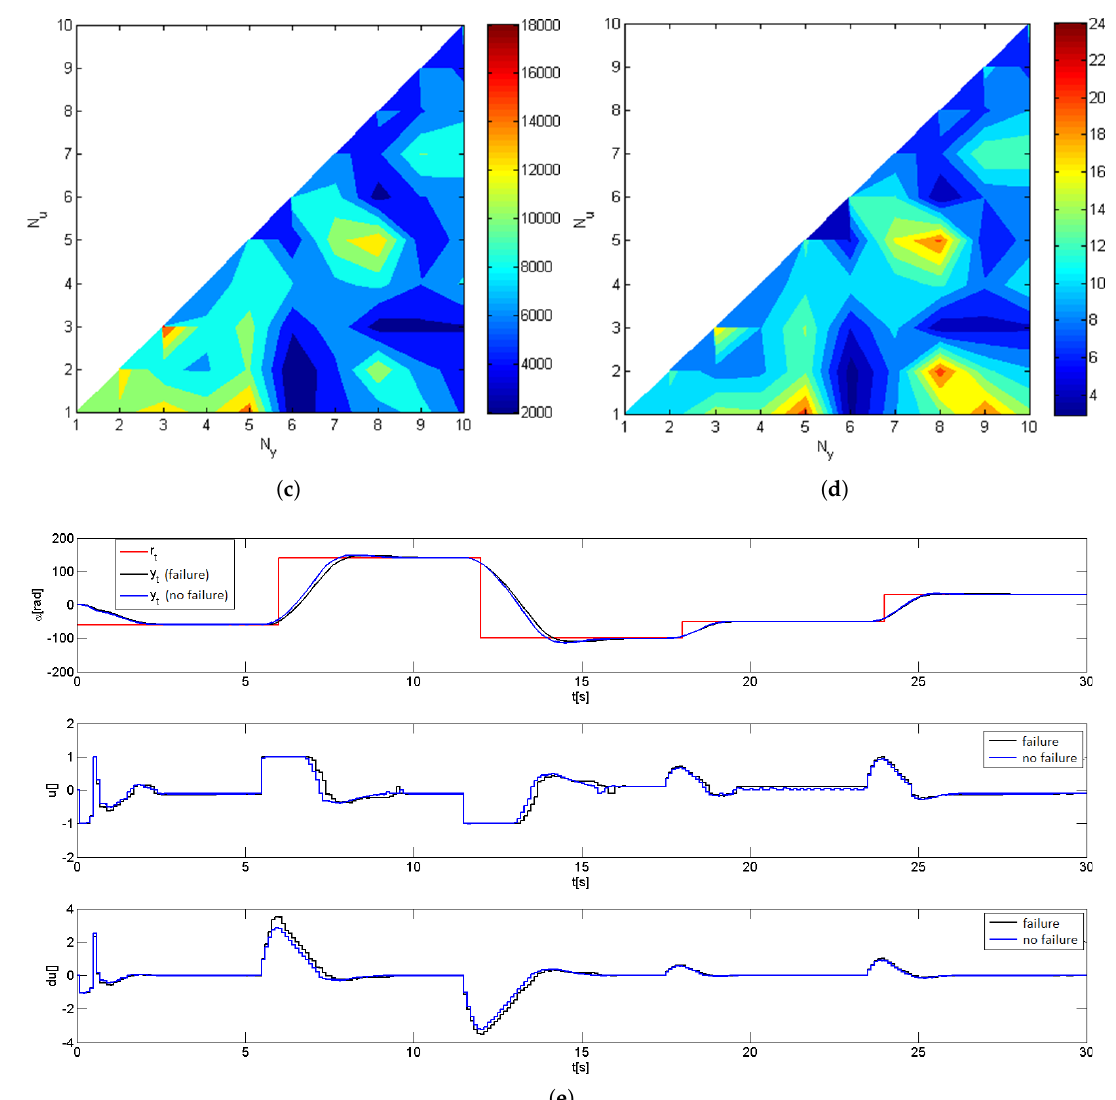
Figure 7. Experimental results concerning sensor failure with q u = 3000, T S = 0.1 s. ( a ) Absolute IAE change; ( b ) Relative IAE change; ( c ) Absolute ISE change; ( d ) Relative ISE change; ( e ) Tracking performance with and without sensor failure, N u = 1, N y =